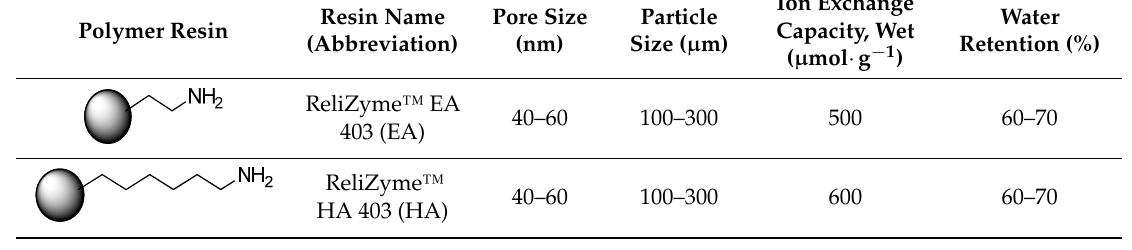
Table 1. Properties of polymer resins with aminoalkyl functions applied for Ca LB immobilization.